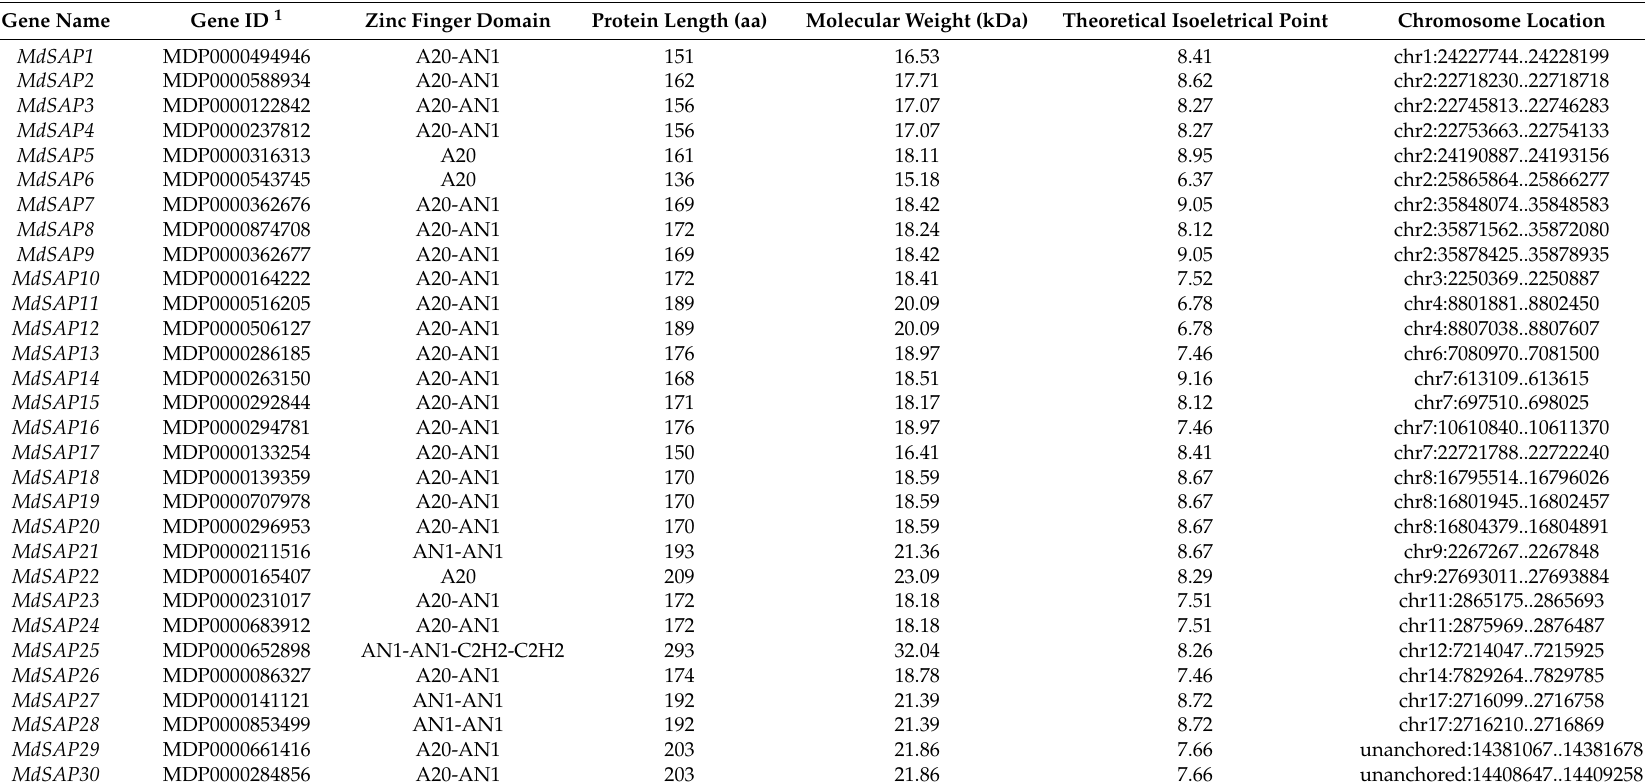
Table 1. Properties of SAPs identified from apple